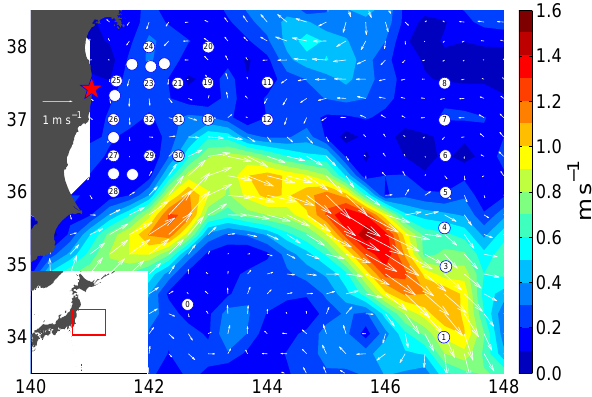
Fig. 1. Station map for the June 2011 cruise, including the location of the Fukushima NPP (red star). The unlabeled station symbols are the location of “half stations” (Table 1). The half stations im- mediately follow the whole number stations along the cruise track (e.g. station 28.5 falls between stations 28 and 29). Color contours represent the current speed in ms − 1 derived from AVISO satellite altimetry